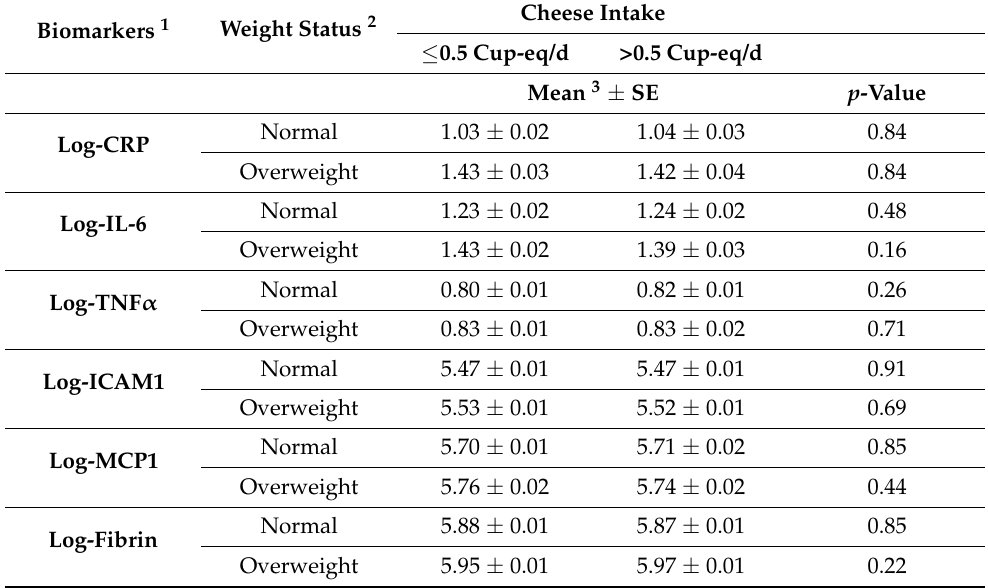
Table 5. Adjusted mean levels of inflammation biomarkers according to combined categories of cheese intake and weight